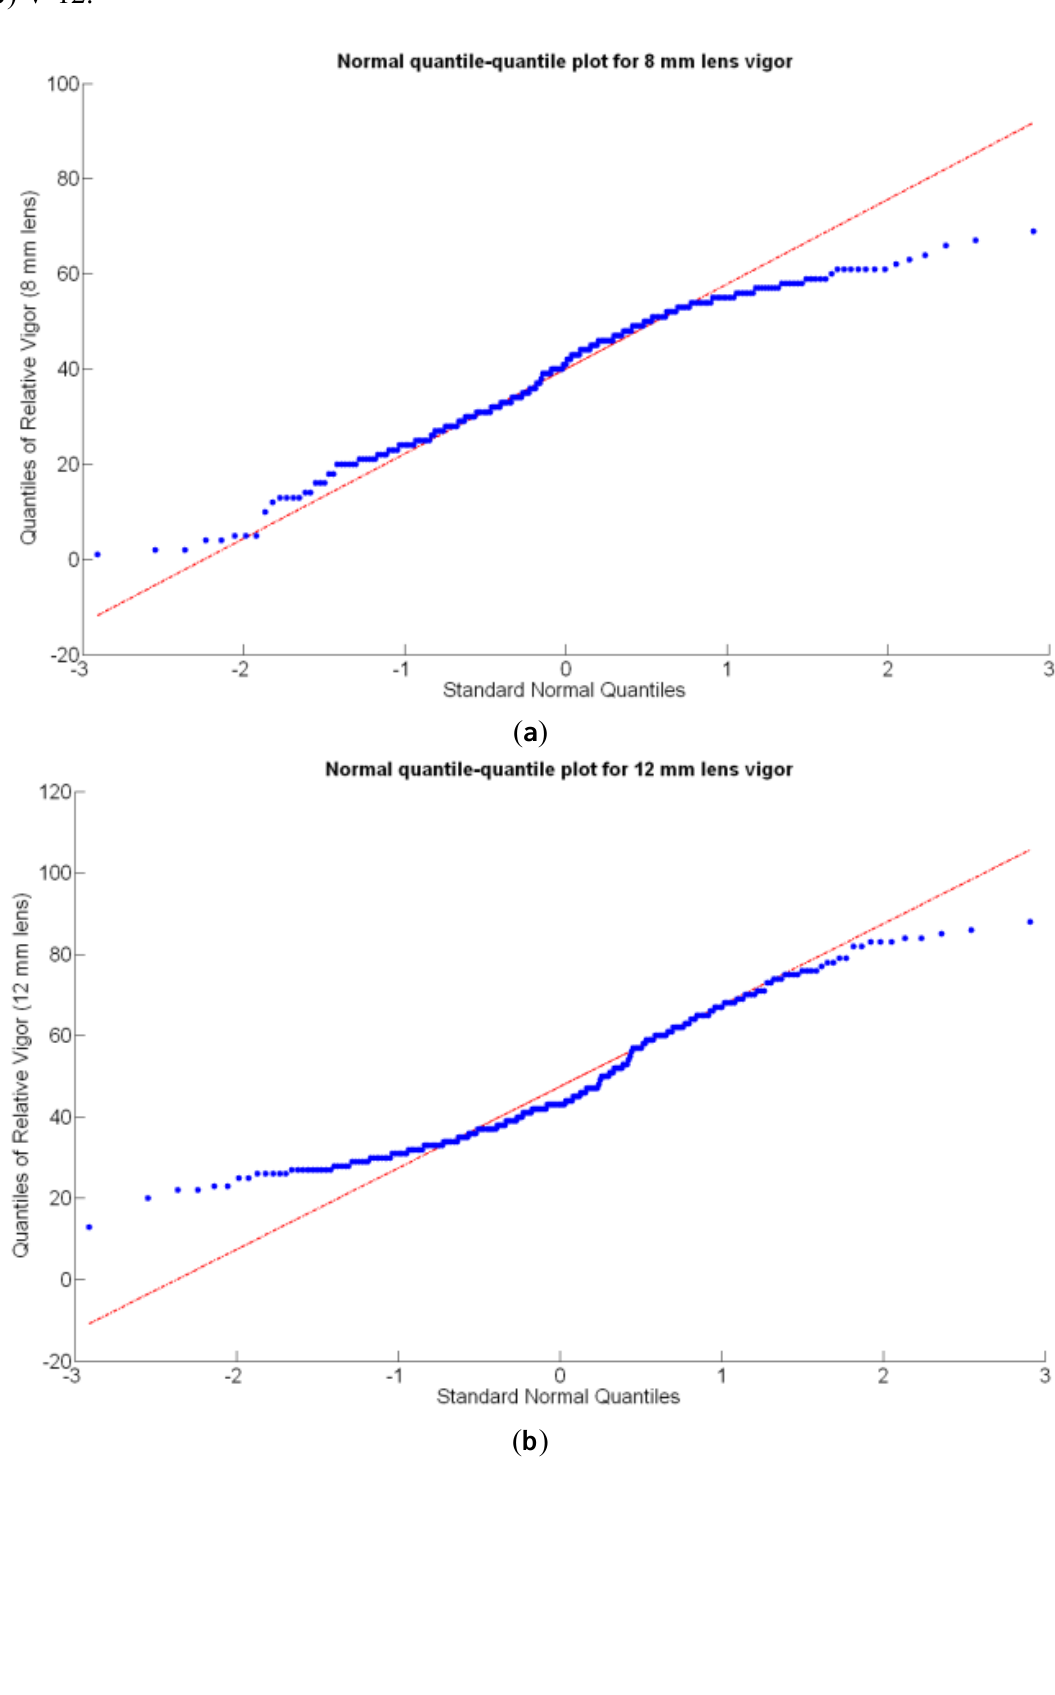
Figure 17. Normal quantile-quantile plots for relative vigor of vines (%): ( a ) V-8; ( b )